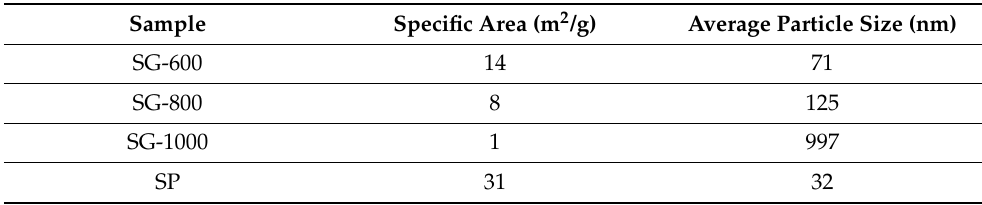
Table 2. Values related to the specific area ( S BET ) and average particle size (D BET ) of the powders obtained by the sol-gel method and heat-treated at different temperatures (600 ◦ C, 800 ◦ C and 1000 ◦ C) and by the sol-precipitation